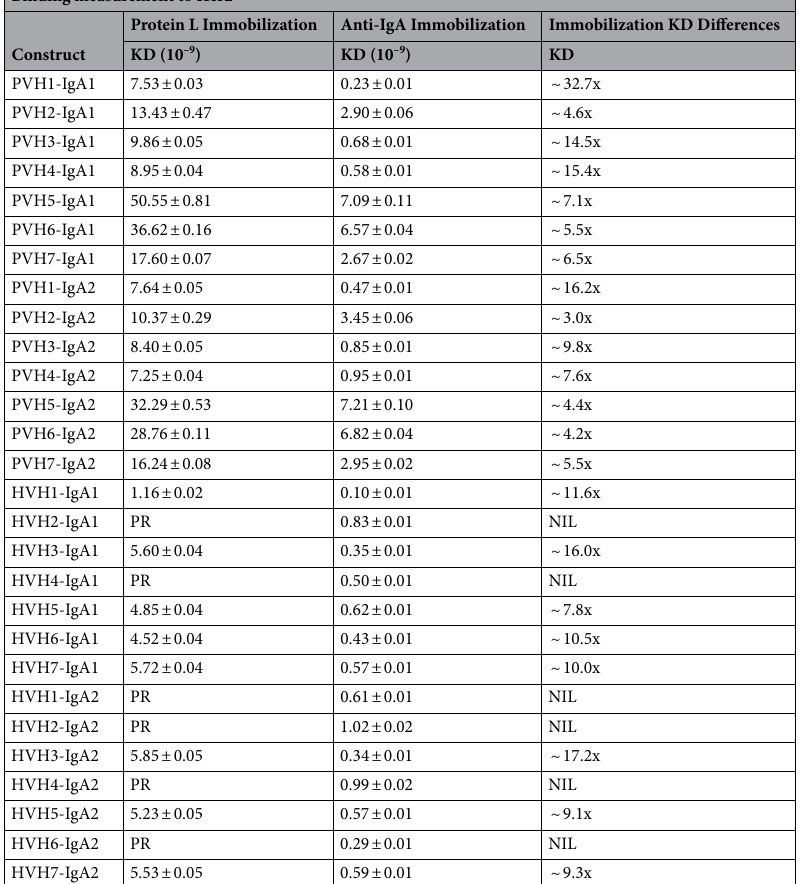
Table 1. BLI measurements of PpL and anti-IgA biosensor immobilized Pertuzumab (PVH) and Trastuzumab (HVH) 1–7 IgA1 and IgA2 interaction to Her2. The KD values with standard error of each variant are shown accordingly. The KD differences between the two immobilization methods are shown in the last column with “x” indicating the fold differences. Poor response (PR) indicates that the antibody construct did not yield reliable ka and kd measurements (in triplicates) and NIL indicates the lack of data (PR) for comparison under Protein L immobilization. All measurements were performed in triplicates and rounded off to the nearest 2 decimal places. The ka and kd values are shown in Supplementary Table